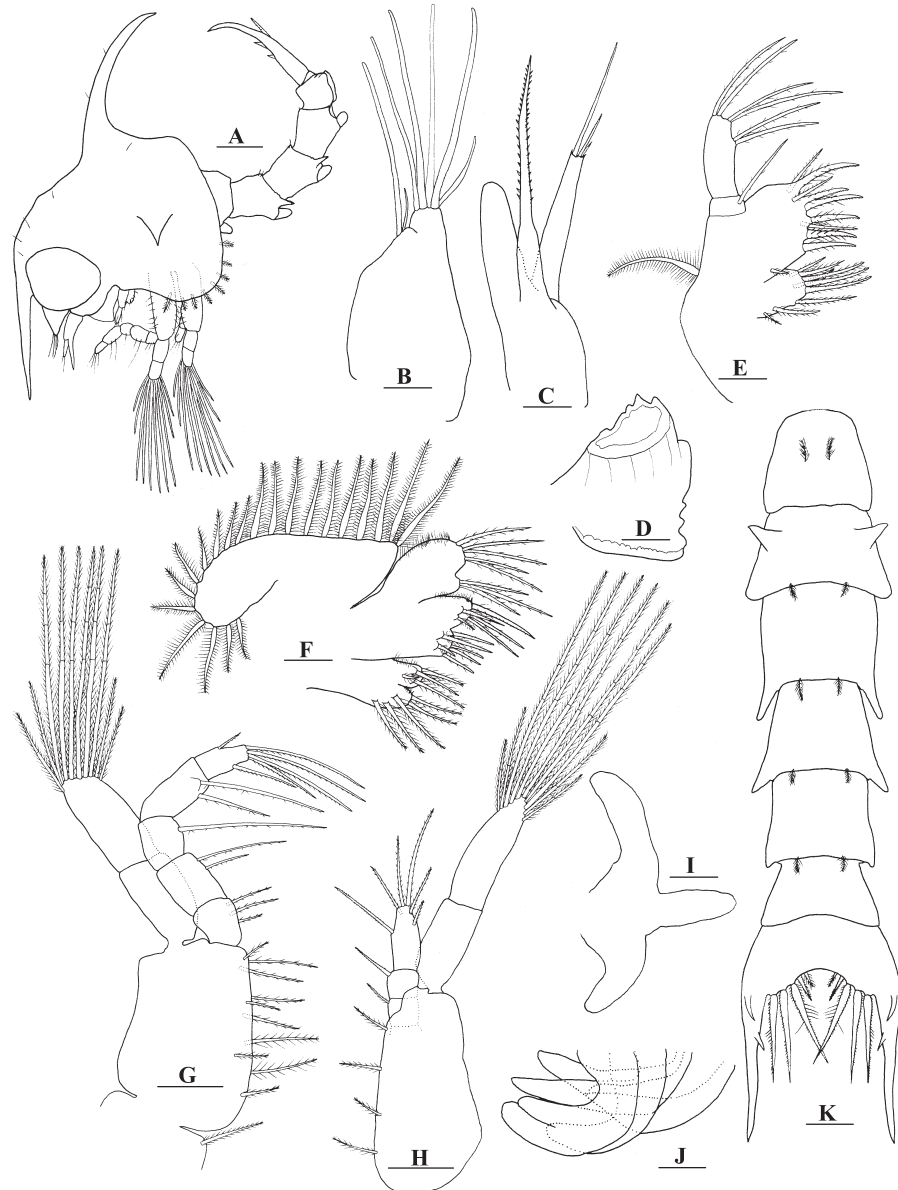
Fig. 4. – Pilumnoides hassleri . Zoea iv. A, whole animal, lateral view; B, antennule; C, antenna; d, mandible; e, maxillule; F, maxilla; G, first maxilliped; h, second maxilliped; i, third maxilliped; J, pereiopods buds; k, abdomen. scale bars. A, 0.2 mm; B-F, 0.05 mm, G-h, 0.1 mm; i, 0.05 mm, J-k, 0.1